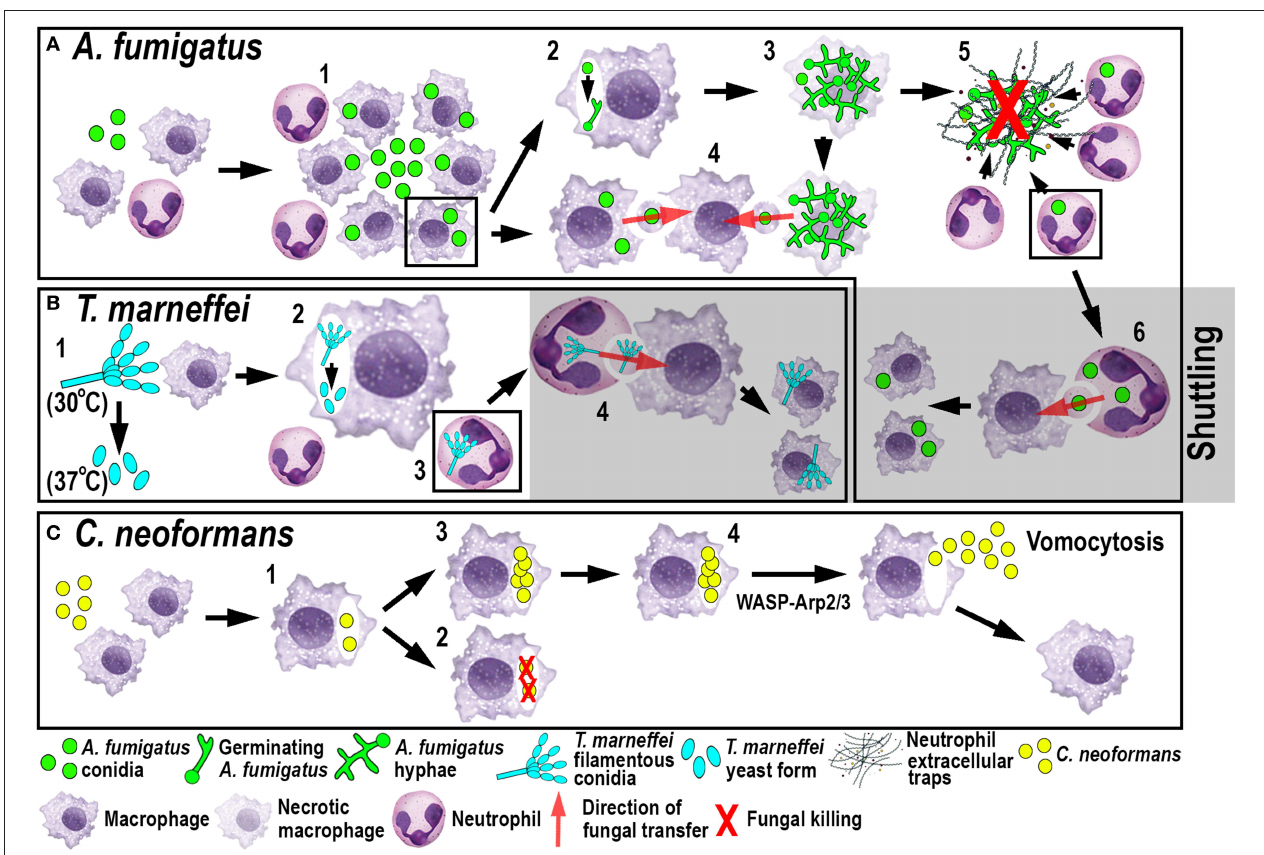
FIGURE 3 | Schematic illustration of phagocyte responses to the fungal pathogens A. fumigatus (A) , T. marneffei (B) and C. neoformans (C) in larval zebrafish. (A) Macrophages phagocytose A. fumigatus conidia and form tight clusters around the fungus, which inhibits fungal germination (1). Fungal germination can occur in the late phagosomes of infected macrophages (2) causing macrophage necroptosis (3). Transfer of A. fumigatus conidia can occur from infected and dying macrophages to recipient macrophages (4). Neutrophils kill A. fumigatus hyphae with their effector functions, including phagocytosis and NETosis (5). Infected neutrophils can transfer A. fumigatus to recipient macrophages through shuttling (6). (B) T. marneffei exists as filamentous conidia at 30 ◦ C and as pathogenic yeast form at 37 ◦ C (1). T. marneffei spores can transition to the yeast form within macrophages (2). Neutrophils can also phagocytose T. marneffei conidia (3) and transfer them to recipient macrophages through shuttling (4). (C) Macrophages phagocytose C. neoformans (1) where it can be killed (2) or persist and proliferate (3). WASP-Arp2/3 regulates vomocytosis and fungal dissemination